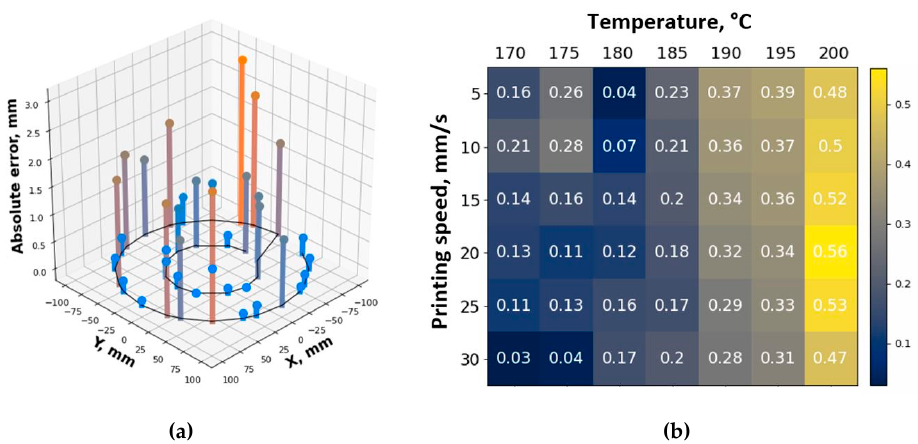
Figure 6. Positioning accuracy and mass accuracy of printed products. ( a ) absolute positioning error at the printing bed level (in millimeters), ( b ) absolute difference between the actual and theoretical weights of the test lines (in grams).